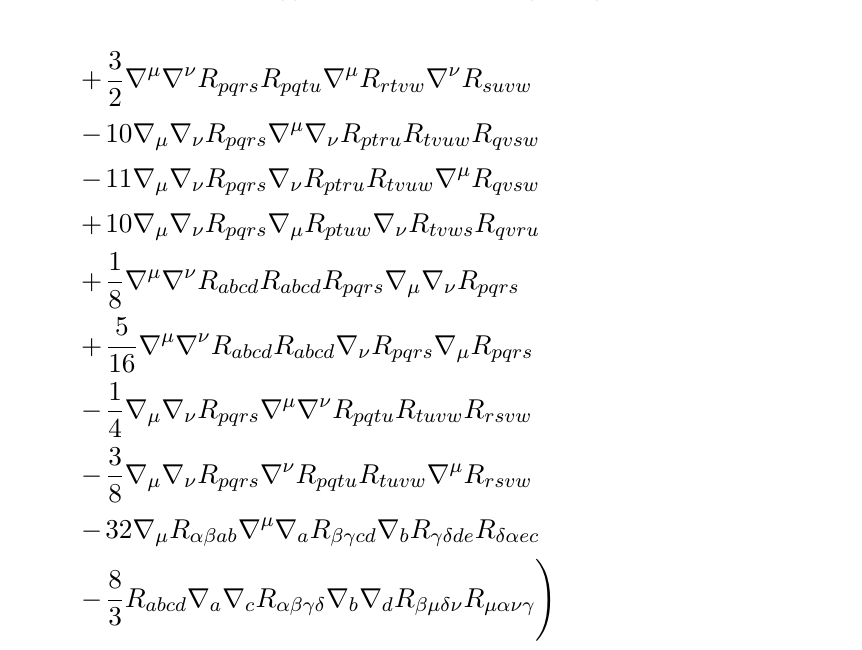
Table 8 . Regge behavior of exchange